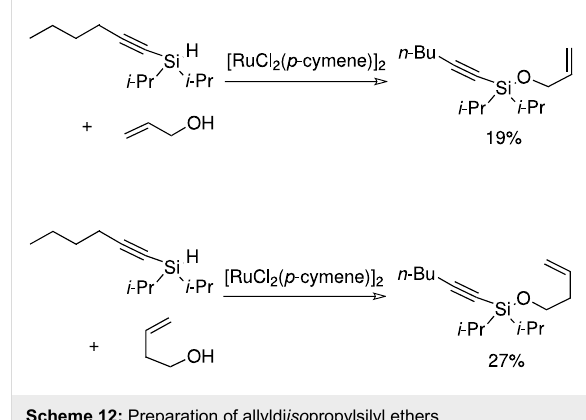
Scheme 12: Preparation of allyldi iso propylsilyl ethers.